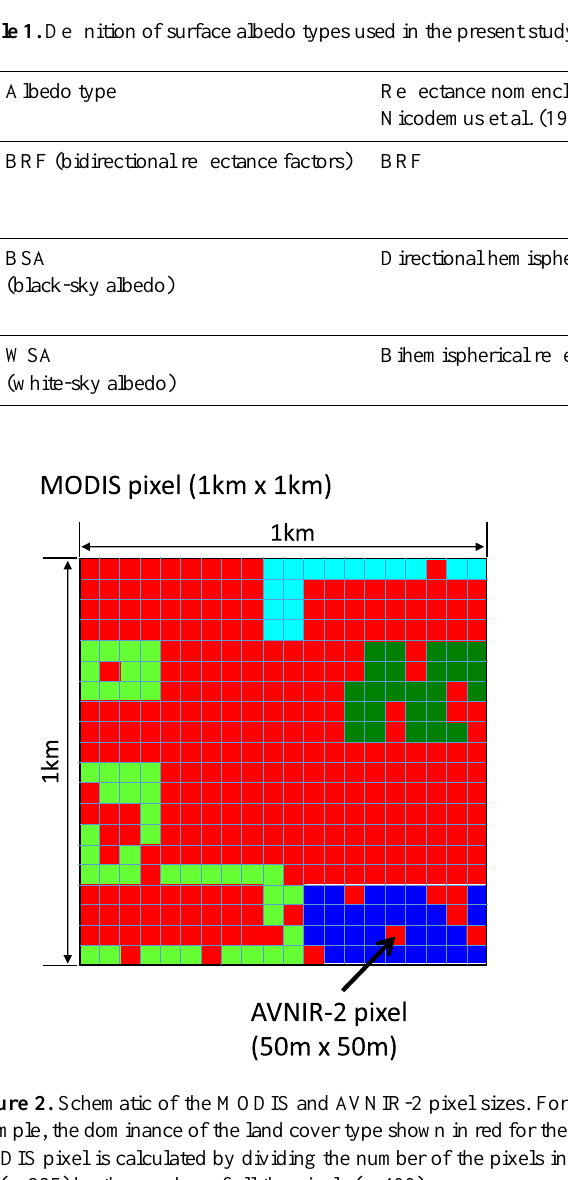
Fig. 2. Schematic of the MODIS and AVNIR-2 pixel sizes. For example, the dominance of the land cover type shown in red for the MODIS pixel is calculated by dividing the number of the pixels in red ( = 285) by the number of all the pixels ( = 400).